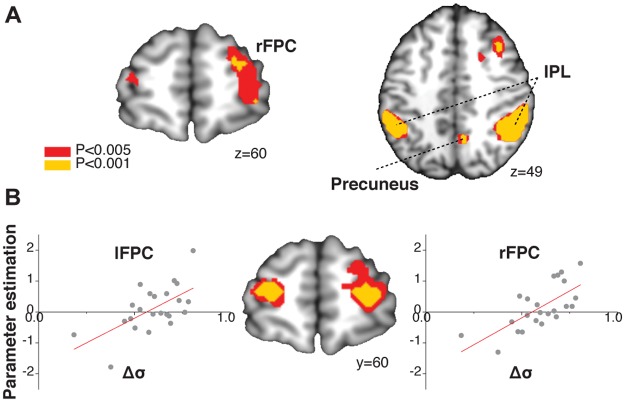
Brain regions engaged in social credibility while integrating social information and individual information to update one’s belief about the preferable judgments.(A) The activity in the right lateral frontopolar cortex (FPC; [x,y,z] = [42,44,19]), in the precuneus (x,y,z) = (18,−58,31), and in the bilateral inferior parietal lobule (x,y,z) = (60,−34.43) and (−54,−49,52) was greater when participants were given the high-credible judgments of the large group than those when they were given the relatively low-credible information of the small group (P < 0.05, whole-brain family-wise error [FWE] corrected at cluster level; general linear model [GLM]2). (B) Whole-brain regression analysis between brain activity and the individual differences, Δσ, represents the ratio between the credibility of social information in the large group and the credibility of social information in the small group. We found that the different activity in the bilateral FPC represented the individual differences in Δσ. That is, participants with greater activation in the FPC showed higher differences in the credibility that they assigned to the judgments of a larger group relative to those of a smaller group (P < 0.05 FWE corrected at the cluster level; GLM2). The functional MRI (fMRI) data can be found in http://neurovault.org/collections/2503/. The data underlying Fig 5B can be found in S1 Data.